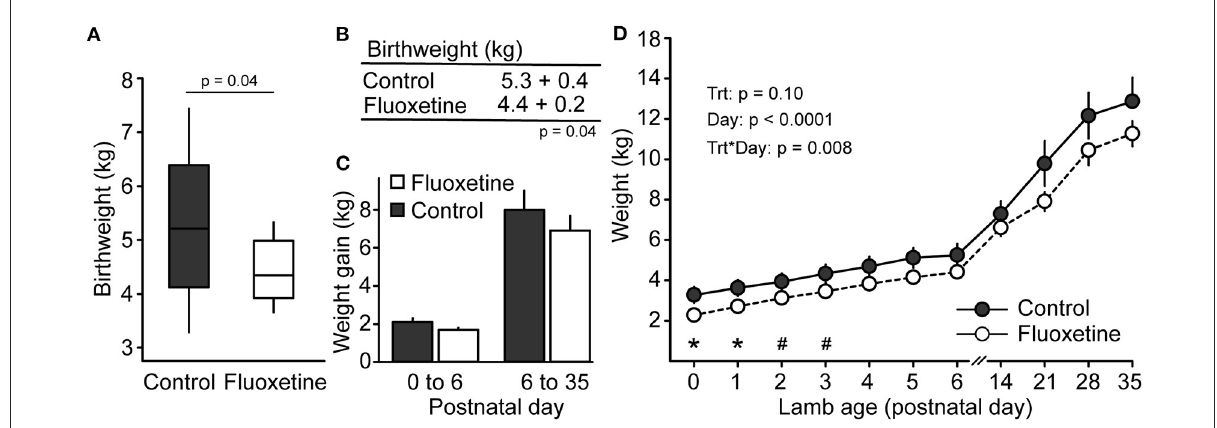
FIGURE4 Lamb weight. (A) Boxplot of neonatal birthweight. Boxplot depicts median, 10th, 25th, 75th, and 90th percentile. (B) Mean lamb birthweight. (C) Lamb weight gain. (D) Lamb weight during the evaluated period. * Indicates significant difference between groups and # indicates a tendency for significance.